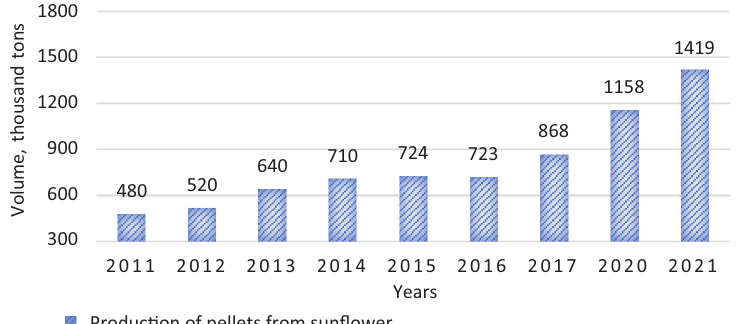
Figure 3. Dynamics of production volumes of pellets and briquettes from sunflower husk in 2011–2021, thousand tons/year (source: Geletukha,